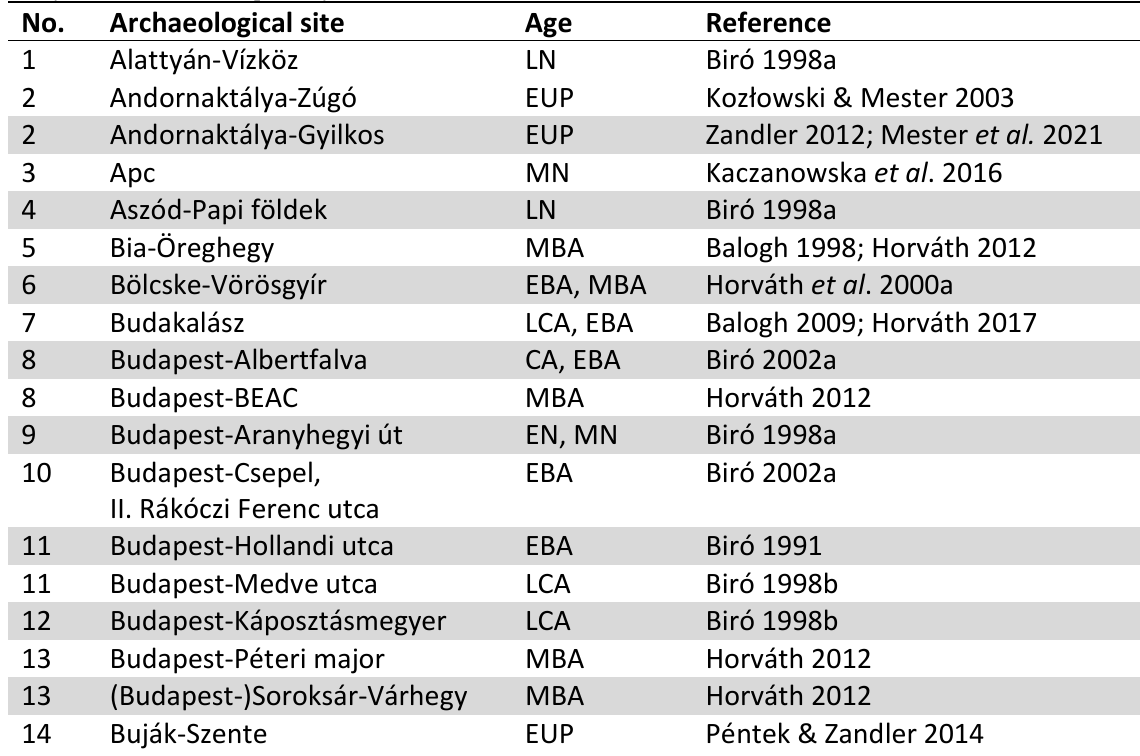
Table 2. Présence des limnosilicites de Mátra et celle de la chaille de Buda aux sites archéologiques (voir Fig. 7). BA: Âge du Bronze; CA: Chalcolithique; EBA: Âge ancien du Bronze; EN: Néolithique ancien; EUP: Paléolithique supérieur ancien; LCA: Chalcolithique récent; LMP: Paléolithique moyen récent; LN: Néolithique récent; LUP: Paléolithique supérieur récent; MBA: Âge moyen du Bronze; Mes: Mésolithique; MN: